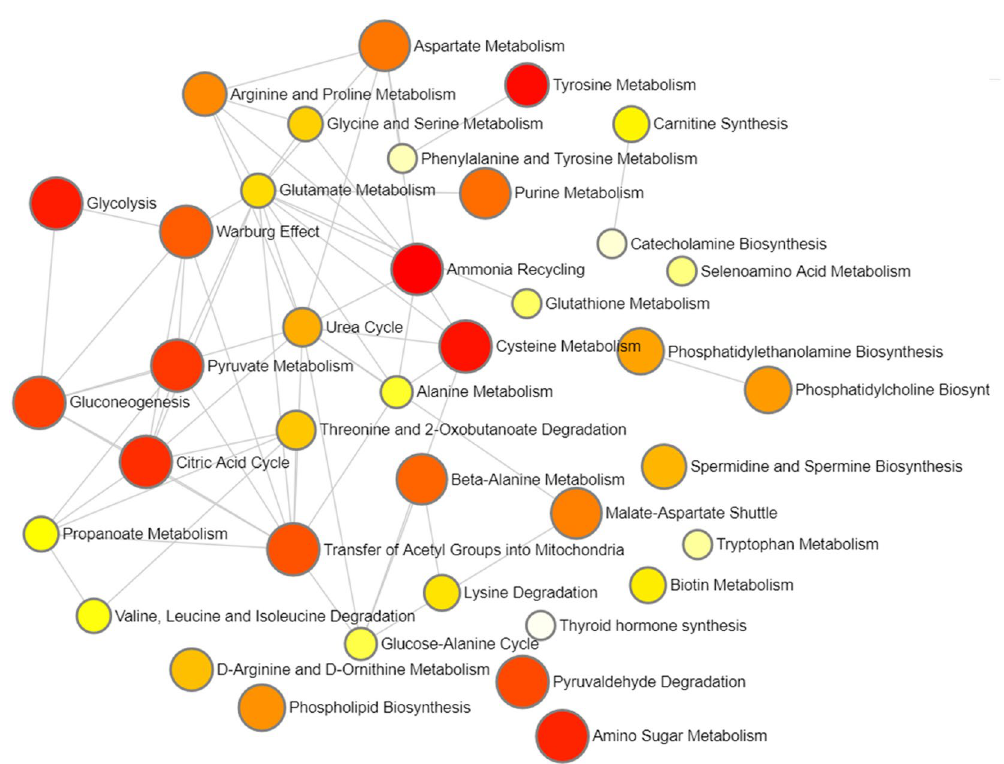
Figure 4. Network analysis illustrating the most significant relationships between perturbed biochemical pathways. Metabolic pathways are represented as circles according to their scores from enrichment (vertical axis) and topology analyses (pathway impact, horizontal axis). Darker circle colors indicate more significant changes of metabolites in the corresponding pathway. The size of the circle corresponds to the pathway impact score and is correlated with the centrality of the involved